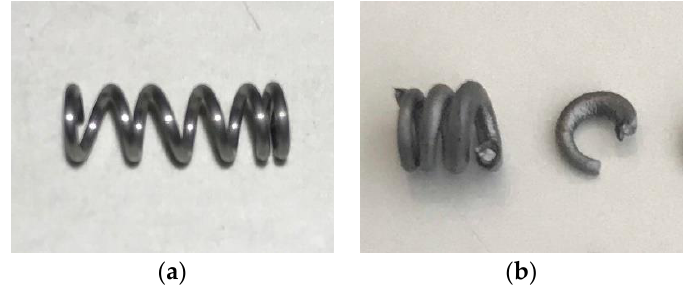
Figure 7. Photographs of the W-filament: ( a ) before use; ( b ) filament debris after beam production with a 150-W power supplied to the filament for six hours.